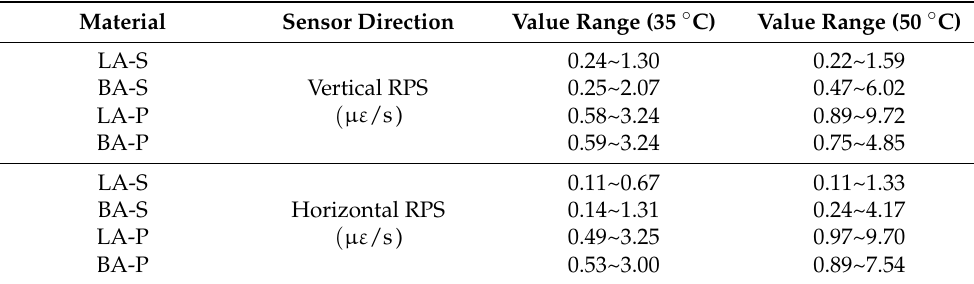
Table 8. The value range of RPS for the four mixtures at 35 ◦ C and 50 ◦